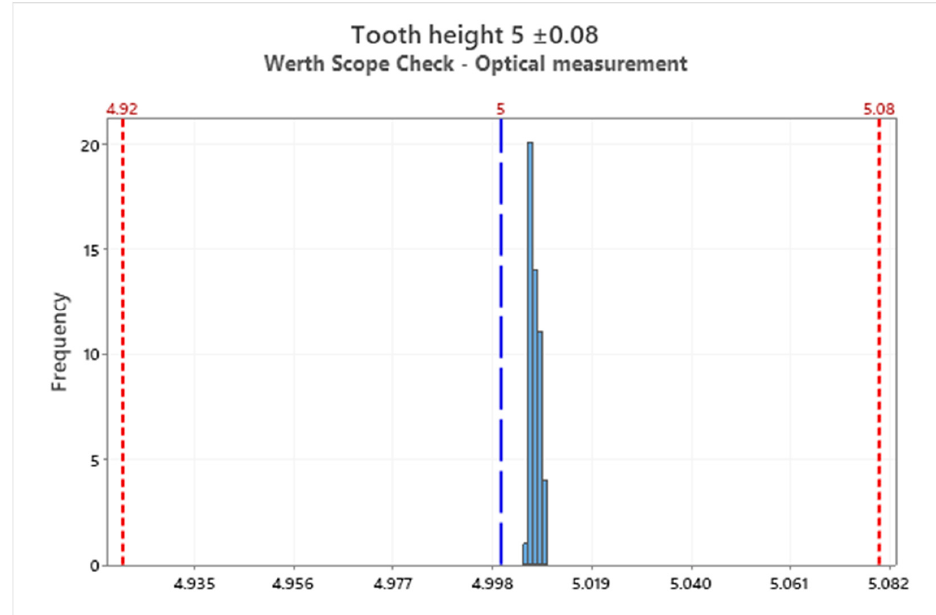
Figure 12. Tooth height 5 ± 0.08 mm—histogram from measurements obtained with the DEA Global Coordinate Measuring Machine, values on x axis given in mm (own study).